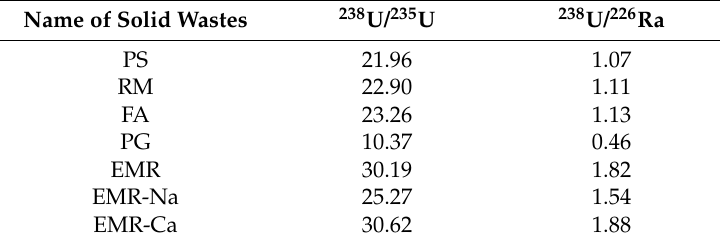
Figure 1. Variation of 238 U activity concentration versus ( a ) 235 U activity and ( b ) 226 Ra activity. Table 5. The activity ratio for different samples under investigation.